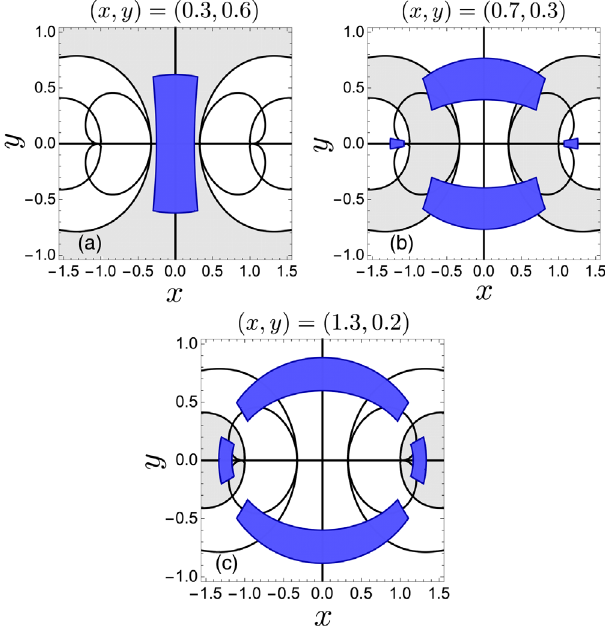
FIG. 7. Level sets (blue) for three distinct initial conditions with 0 , reflecting three distinct types of orbit geometry at p p x ¼ y ¼ the nominal insert strength τ ¼ − 0 . 4 . The set of critical initial conditions is shown in black. (a) The orbit is symmetric about the x - and y - axes. (b) The orbit is confined to the upper half-plane. (c) The orbit is confined to the right half-plane.